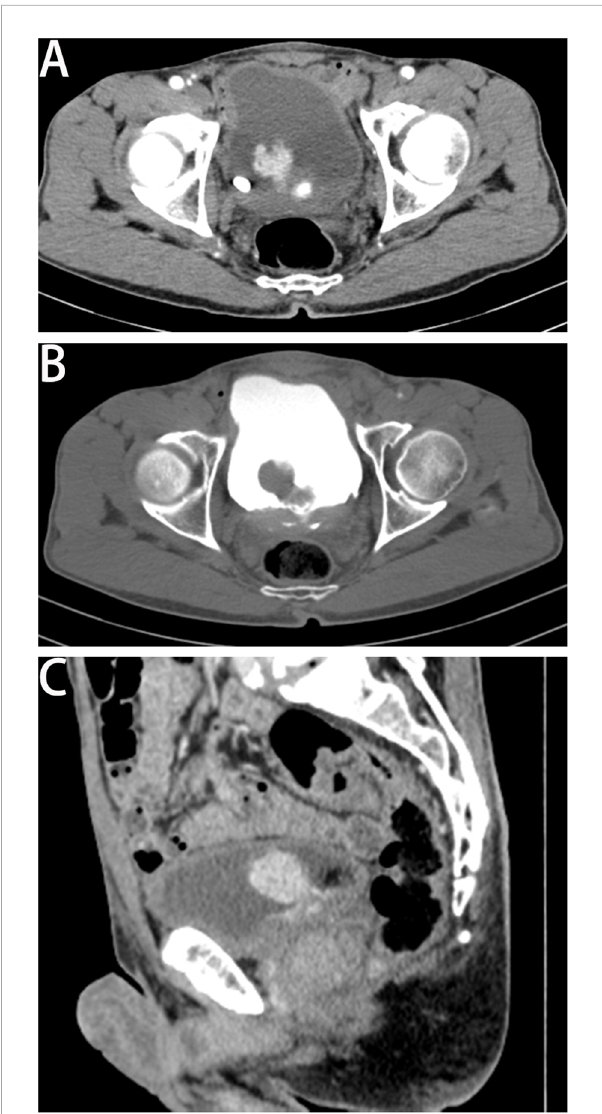
FIGURE 1 Results of computed tomography urography. Cross sections: panel (A) (arterial phase) and panel (B) (delay 2 phase). Sagittal section: panel (C) showed a lobulated tumor located in the bladder ’ s posterior wall with its clear boundary. The size was approximately 3.5 × 2.4 × 2.1 cm. The enhanced CT scan indicated that the tumor was signi fi cantly